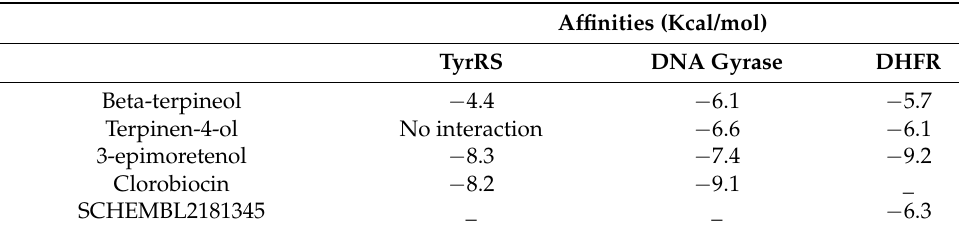
Table 4. Affinity results of the selected receptors and molecules.